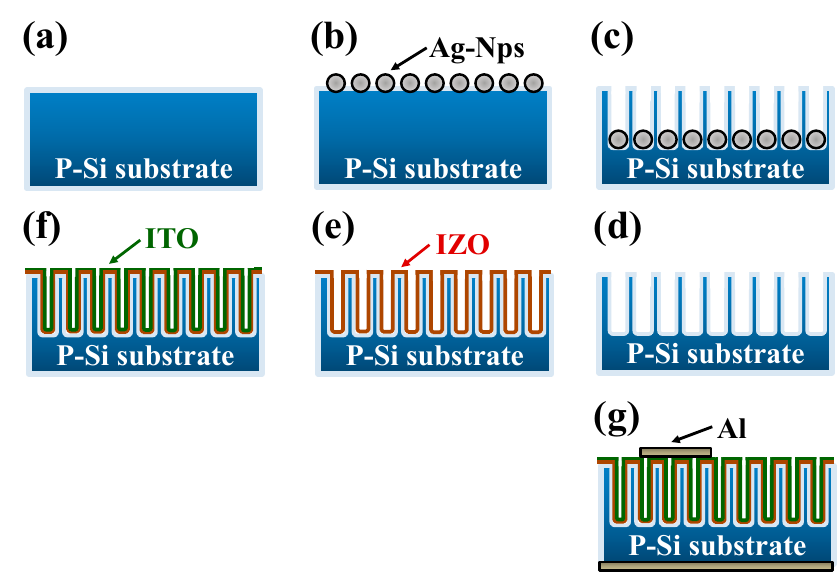
Figure 1. A schematic illustration of the procedure for fabricating the ITO/IZO/silicon nanowire (SiNW) heterojunction diode device.